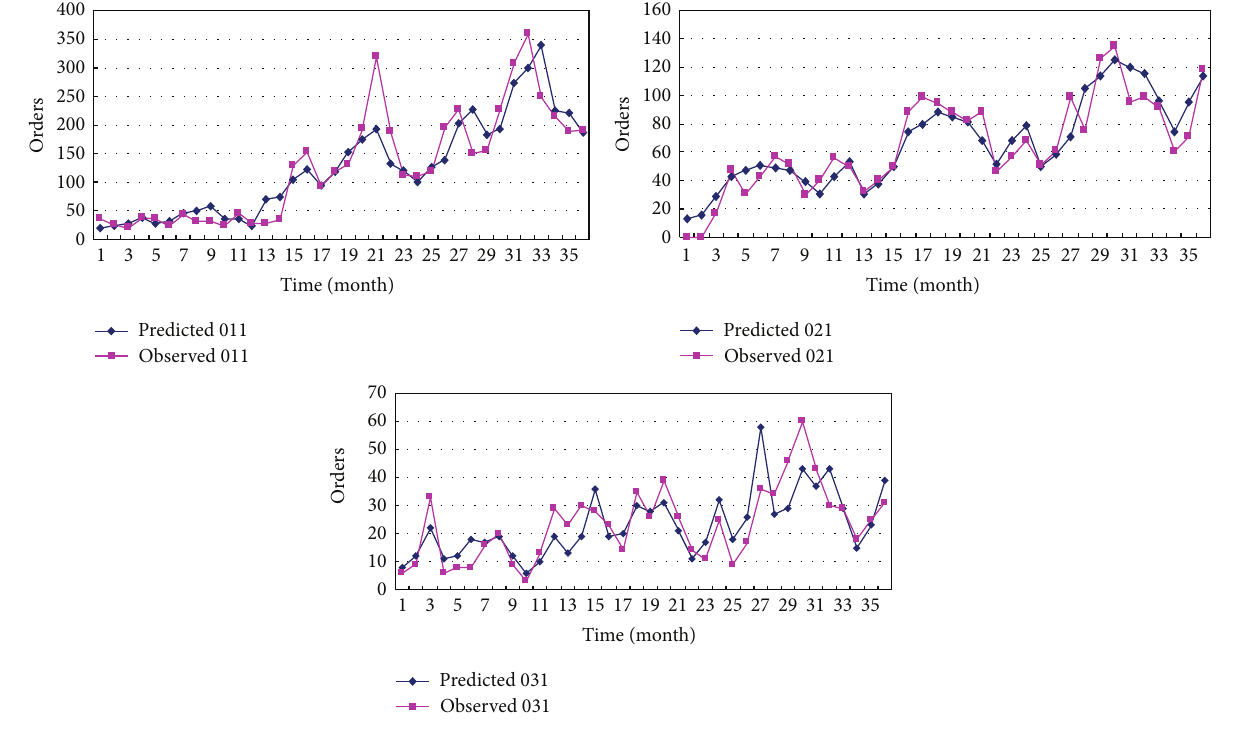
Figure 7: The orders of container transportation predicted by the polynomial model.